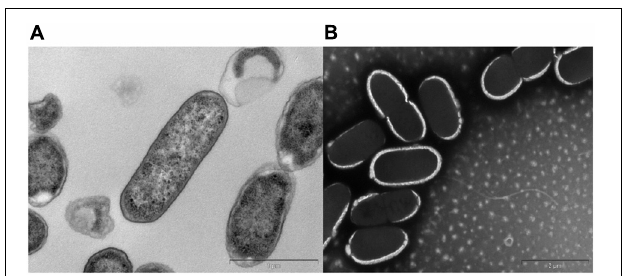
FIGURE 1 | Transmission electron micrographs of Citrobacter sp. KVM11. Bacterial cells were fixed in electron microscopy fixative (4% paraformaldehyde/1.25% glutaraldehyde in PBS, + 4% sucrose, pH-7.2) and washed with buffer. (A) Transverse section of the polymerized cells of KVM11, bar scale 100 nm (B) Negatively stained cells of KVM11 with filaments, bar scale 200 nm. The samples were prepared using a heavy metal staining method involving phosphotungstic acid. Samples were examined in an FEI Tecnai G2 Spirit Transmission Electron